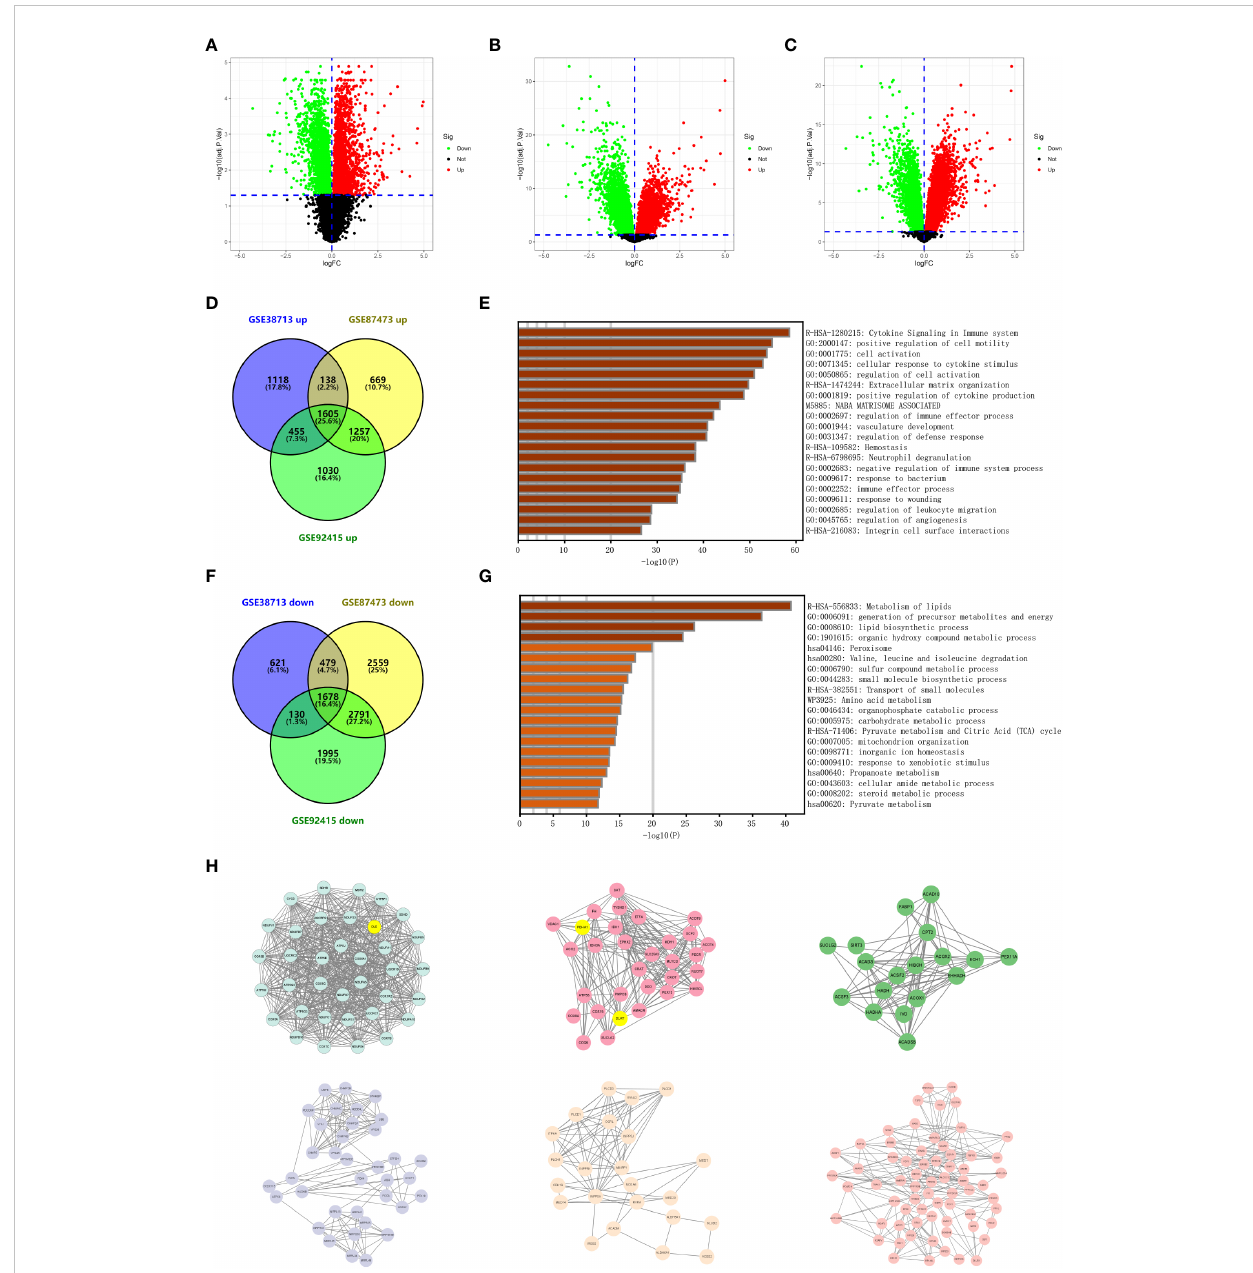
FIGURE 1 Identi fi cation of differentially expressed genes in ulcerative colitis. (A) Volcano plot depicting the differentially expressed genes of microarray GSE38713. Red data points represent upregulated genes and green data points represent downregulated genes. Genes without any signi fi cant differences are in black. (B) Volcano plot depicting the differentially expressed genes of microarray GSE87473. Red data points represent upregulated genes and green data points represent downregulated genes. Genes without any signi fi cant differences are in black. (C) Volcano plot depicting the differentially expressed genes of microarray GSE92415. Red data points represent upregulated genes and green data points represent downregulated genes. Genes without any signi fi cant differences are in black. (D) The Venn diagram depicts the overlap of upregulated genes between the three datasets retrieved from the GEO database. (E) Functional enrichment analysis of overlapping upregulated genes. The bar graph depicts the top 20 results of the upregulated gene enrichment analysis; p -values are differentiated by shades of color. (F) The Venn diagram depicts the overlap of downregulated genes between the three datasets retrieved from the GEO database. (G) Functional enrichment analysis of overlapping downregulated genes. The bar graph depicts the top 20 results of downregulated gene enrichment analysis; p -values are differentiated by shades of color. (H) The key subnetworks in the PPI network are calculated using the MCODE algorithm in Cytoscape software, and the subnetworks with the highest weights and the sixth ranked subnetworks are presented from the top left to the bottom right,